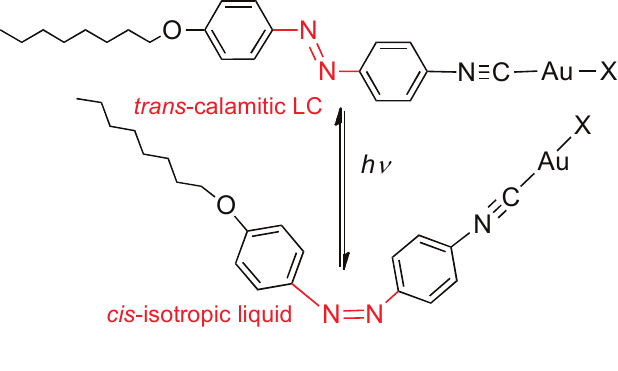
Figure 7. Changes in azo isocyanide gold mesogens after irradiation with a laser. X = Cl, F ; alkoxy chain with n = 4, 8, 12. C 6 5